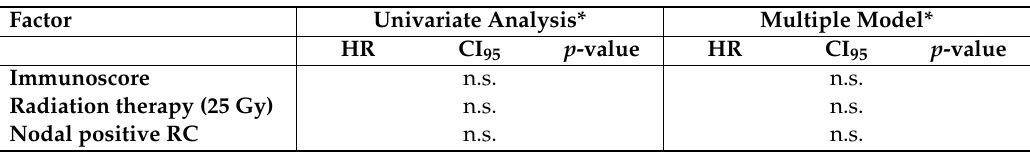
Table 7. Univariate and multiple Cox Regression analysis for disease-free survival of rectal cancer patients using the Immunoscore (2 cores per tumor area, virtual